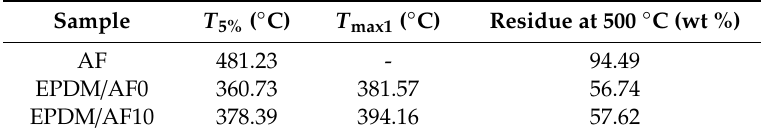
Figure 7. SEM of the sample EPDM/AF 10 fired at 350 °C for 20 min: ( a ) ×500; ( b ) ×1000.